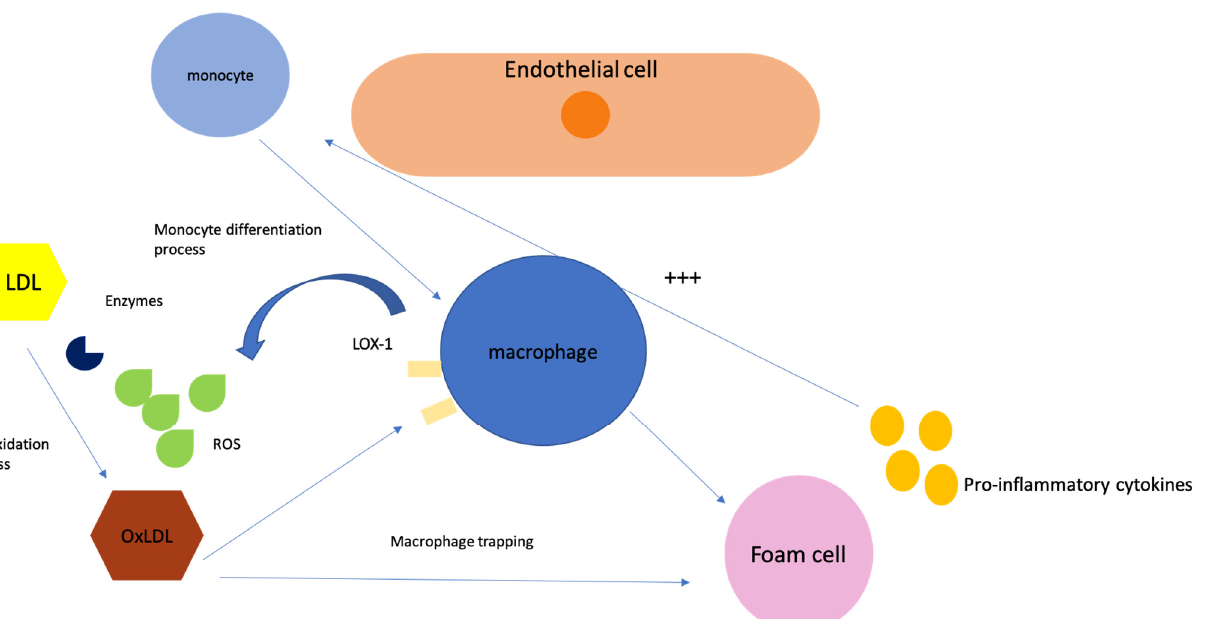
Table 2. Overall characteristics of small, dense low-density lipoproteins (sdLDL) summarized as a series of sequential processes.